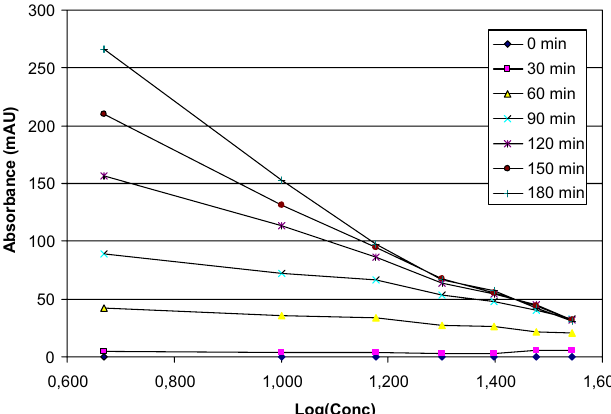
FIGURE 4 - Graph of absorbance (mAU) vs. logarithm of apramycin concentration ( m g mL -1 ) employing tryptone soy broth inoculated with Escherichia coli (ATCC 8739) at 5% after 0, 30, 60, 90, 120, 150 and 180 minutes of